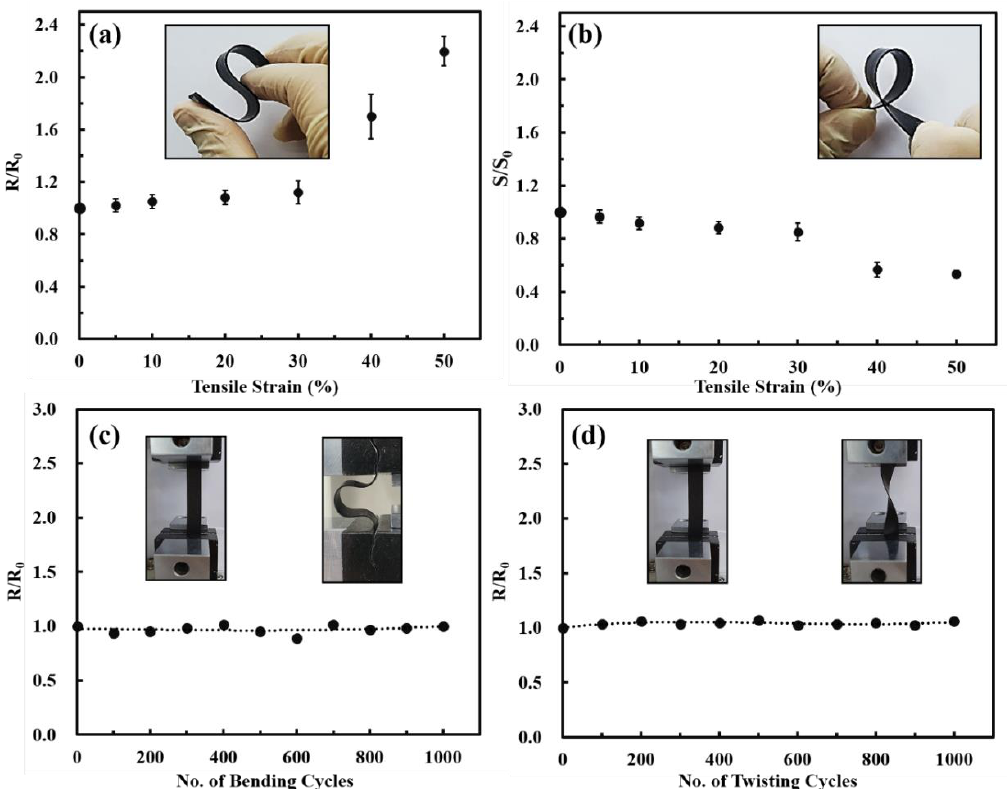
Figure 6. ( a ) Normalized resistance and ( b ) Seebeck coefficient of ~500 nm thick 25 bilayer PEO/DWNT-PAA as a function of tensile strain. Normalized resistance of 25 bilayers of PEO/DWNT- PAA in cyclic ( c ) bending and ( d ) twisting tests. Each inset photo shows the bending and twisting process. The normalized Seebeck coefficient of 25 bilayers of PEO/DWNT-PAA by cyclic bending and twisting is shown in the Supporting Information (Figure S4).